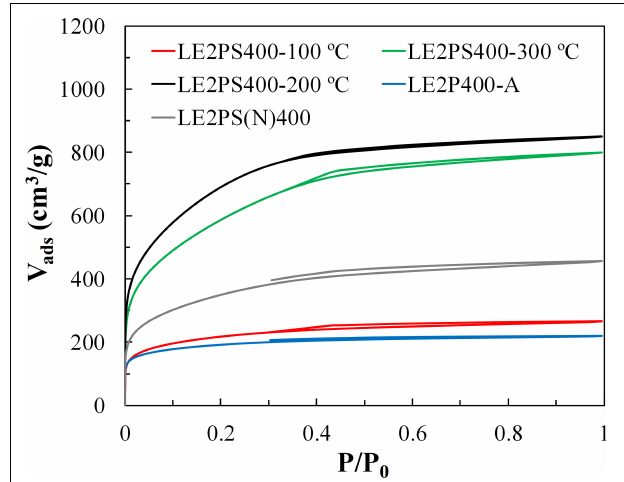
FIGURE 9 | N 2 adsorption-desorption isotherms obtained at –196 ◦ C of the different activated carbons obtained at 400 ◦ C and H 3 PO 4 /lignin mass ratio of 2, treated at different